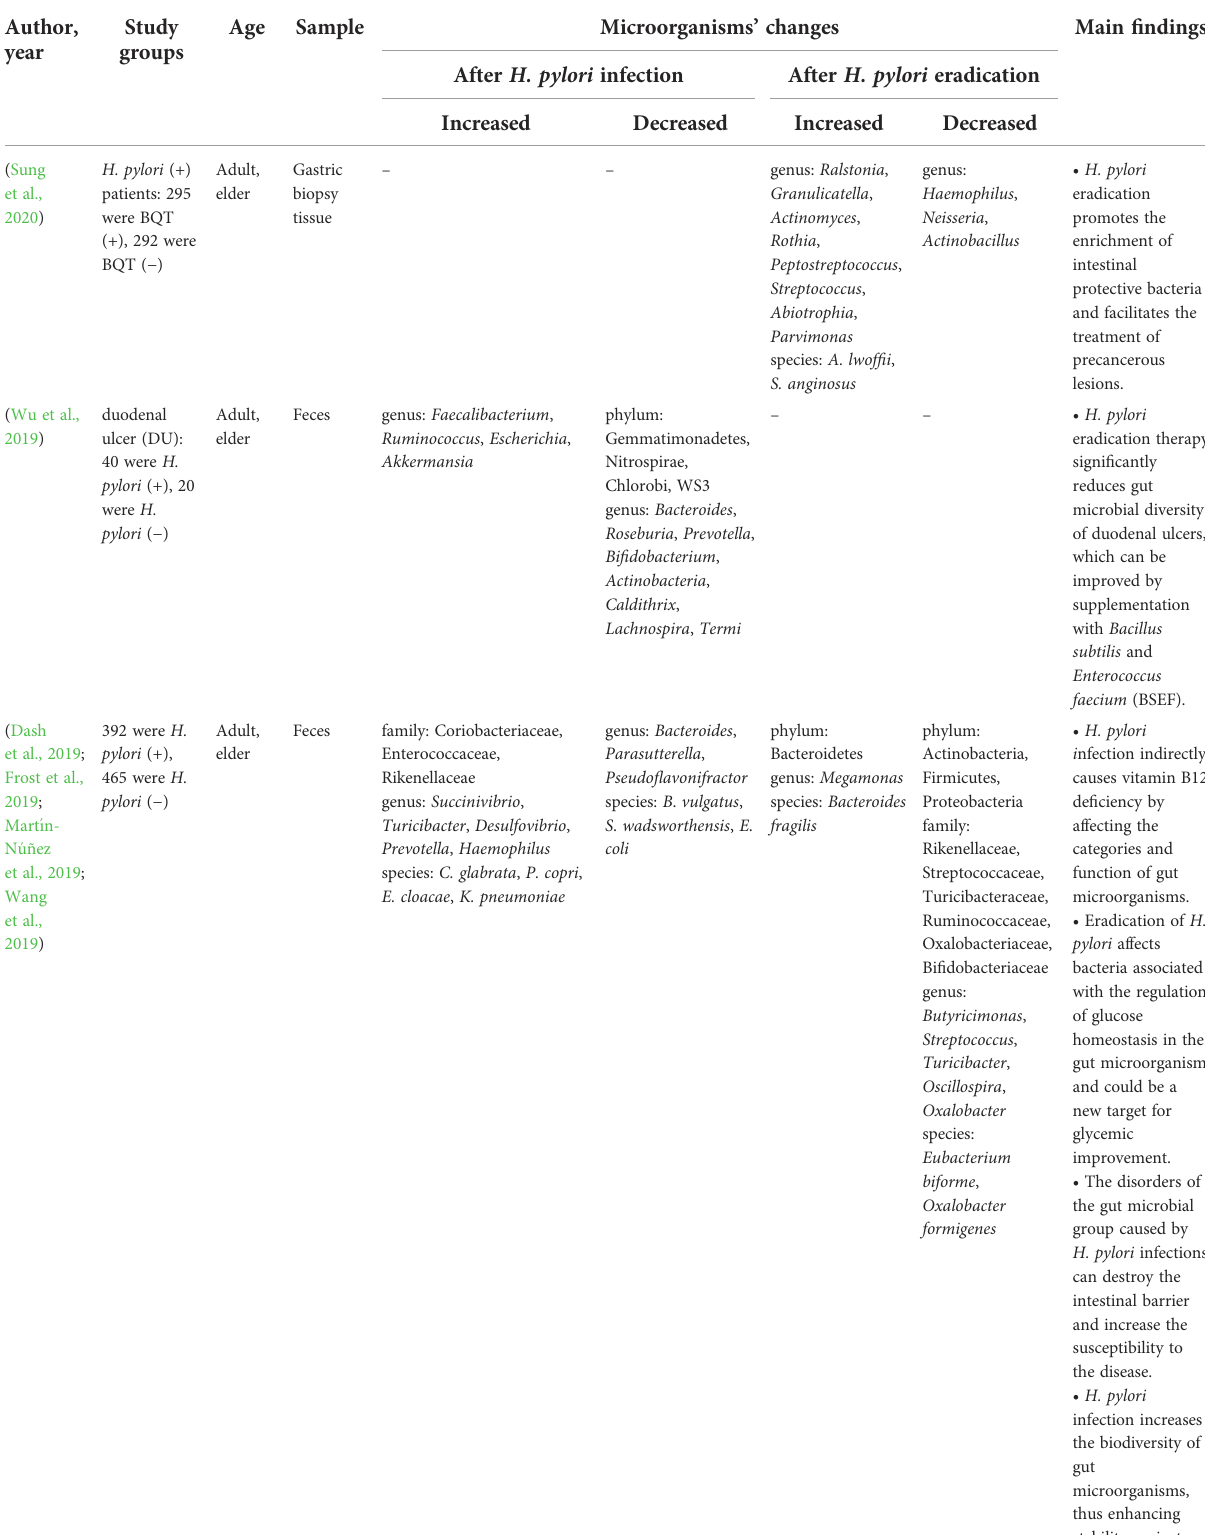
TABLE 2 Studies assessing the in fl uence of Helicobacter pylori (H. pylori ) infection on gut